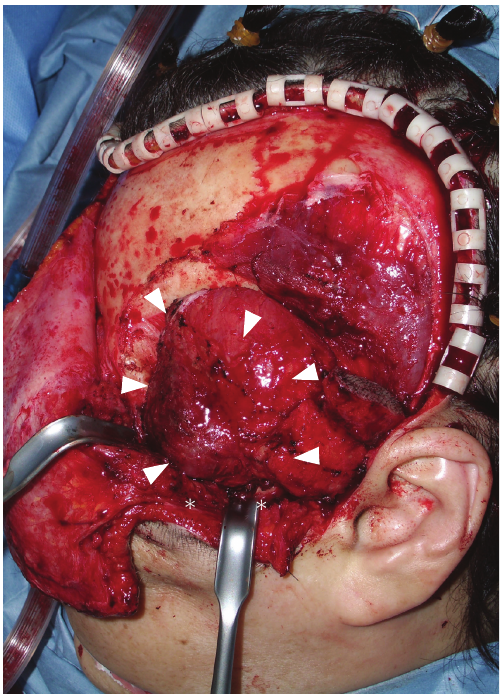
Figure 4: Intraoperative view demonstrating intramuscular tumor (arrows) with the assistance of zygomatic osteotomy